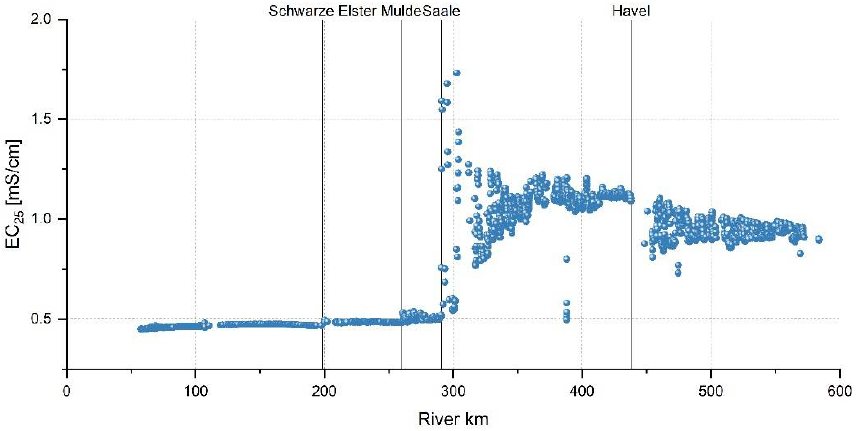
Figure 11. EC 25 plotted against river km of the Elbe River. Major tributaries are marked with black lines. A significant increase and high variation in EC 25 can be observed after the mouth of the